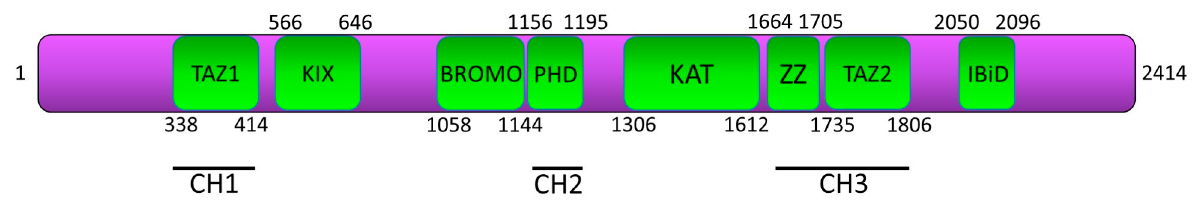
Figure 1. p300 structural domains and their localization. TAZ1 (also known as CH1), KIX, BROMO, PHD (also known as CH2), KAT, ZZ and TAZ2 (together known as CH3), and IBiD. Approximate domain boundaries were taken from the p300 Pfam database entry (Q09472).